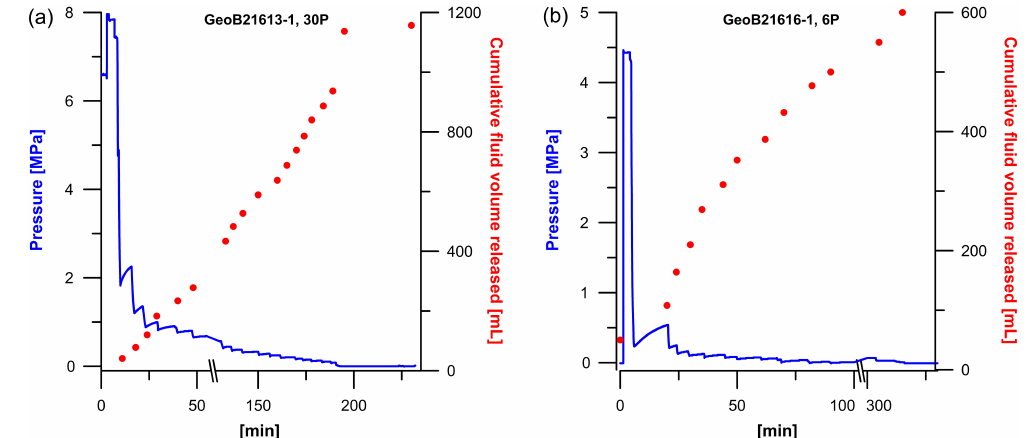
Figure 4. Degassing characteristics of two pressurized sediment cores collected with MeBo70 during cruise MSM57/1. (a) Pressure and cumulative fluid volume released vs. time during degassing of section GeoB21613-1 (30P). (b) Pressure and cumulative fluid volume released vs. time during degassing of section GeoB21616-1 (6P).